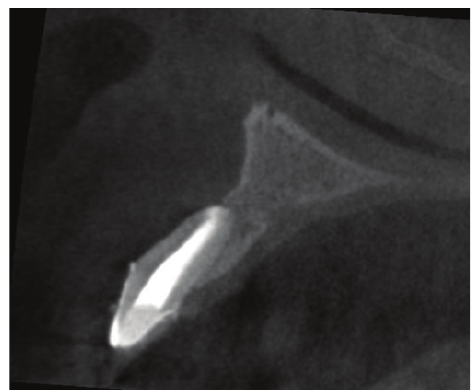
Figure 49: 1-year followup CBCT image in sagittal plane.